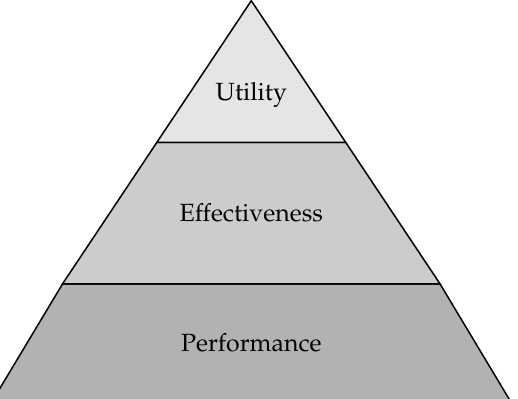
Figure 2. In LiCausi’s depiction of the MS&A hierarchy, there are three levels of analysis: performance analysis, effectiveness analysis, and utility analysis. Simulation models typically support analysis at one of these levels, and a family of models are needed for multiple levels of analysis. Adapted from